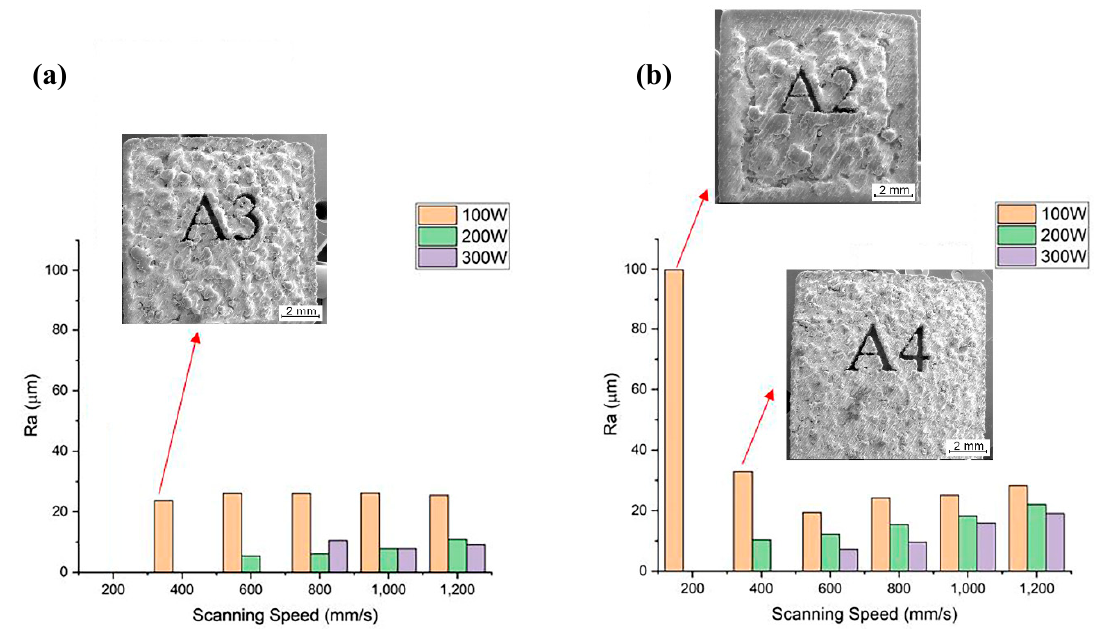
Figure 9. Surface roughness measurements: ( a ) h = 80 µm and ( b ) h = 120 µm.